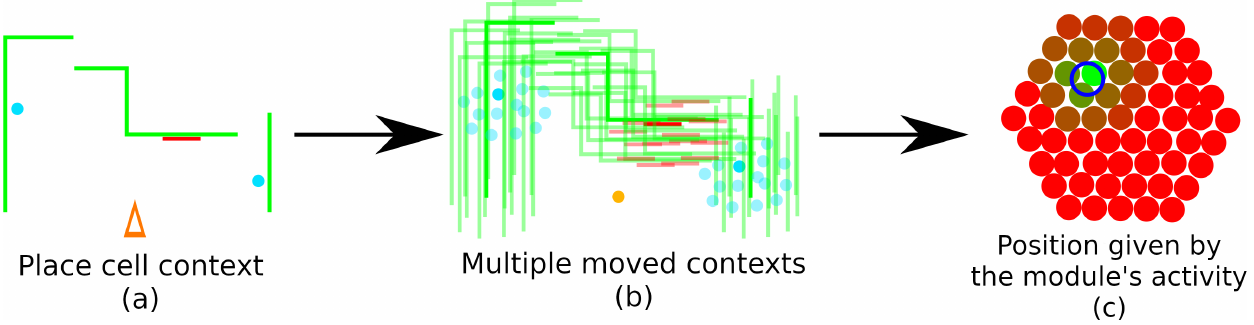
Figure 6. Principle of grid cell localization and odometry: a place cell is associated with a grid cell of a module. When the place cell becomes active ( a ), grid cells of the module generate alternatives of the place cell’s context, translated by the relative movement between each grid cell of the module and the grid cell associated with the place cell ( b ). The activity of grid cells in the module allows estimation of the agent’s current position and movements in the place cell’s reference ( c